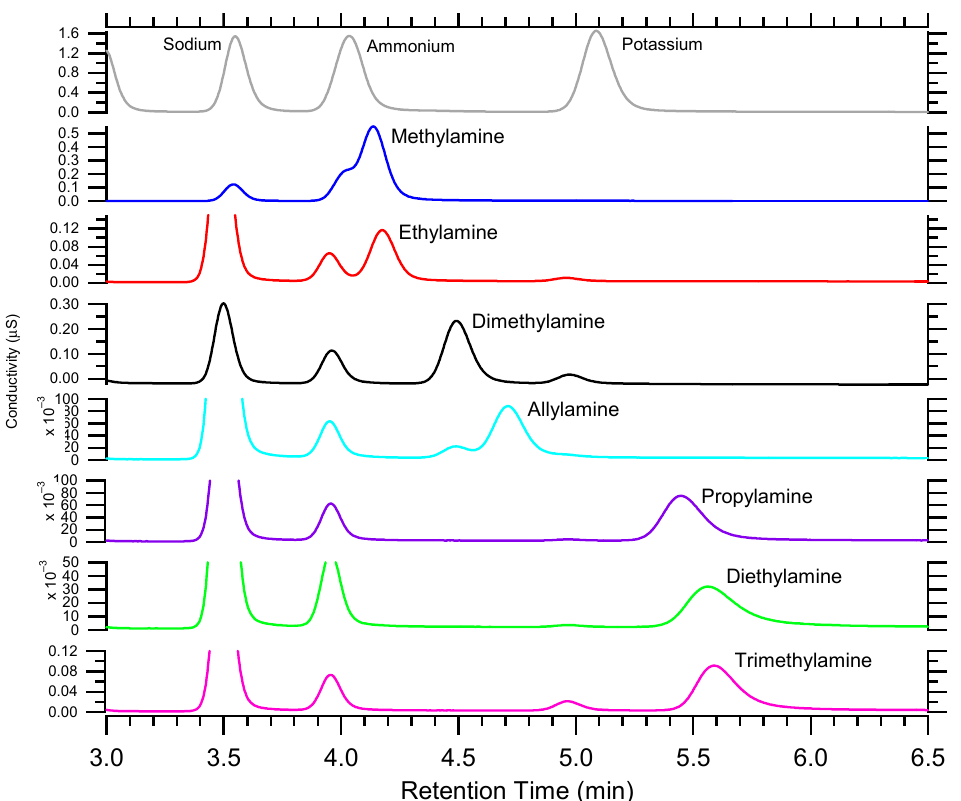
Figure 2. Chromatogram comparison of a cation and seven di ff erent amine calibration standards. The separation was performed on a Thermo Scientific Dionex IonPac CS-12A (3 × 150 mm) column using an isocratic method with an eluent of 20 mM methanesulfonic acid at a flowrate of 0.5 mL min − 1 . Note only data from 3 to 6.5 min is being shown to illustrate the challenges with using this column to simultaneously measure the + 1 inorganic cations and amines. It is observed that methylamine and ethylamine, as well as propylamine, diethylamine, and trimethylamine, overlap. In addition, there is overlap of ammonium with methylamine and ethylamine. Depending on the size of the ammonium peak, this could extend to dimethylamine and allylamine. Therefore, the ammonium concentration would be overestimated as these amines are being included in the integration of the ammonium peak. The same could be true for potassium, depending on the size of its peak, with propylamine, diethylamine, and trimethylamine.